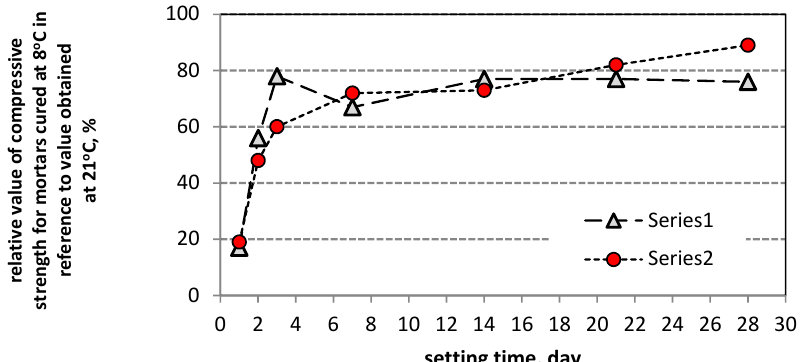
Figure 9. Compressive strength increase rate of mortars cured at 8 ° C, in reference to the values obtained in the same period for mortar setting at 21 ° C.